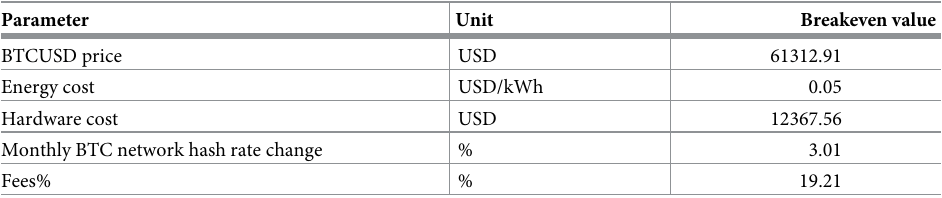
Table 5. Summary of breakeven values for all crucial